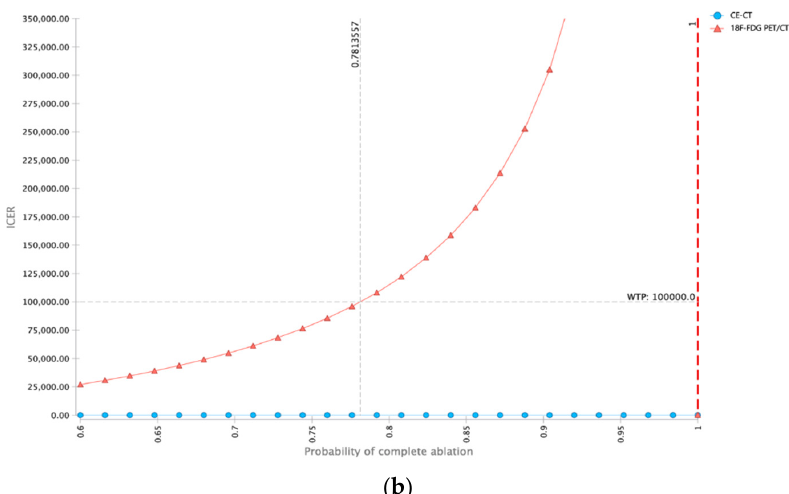
Figure 2. Deterministic sensitivity analysis. ( a ). Tornado diagram showing the impact of input parameters on incremental cost-effectiveness ratio (ICER) starting from expected value (EV) in base case scenario. For every parameter range investigated, the ICER of 18F-FDG PET/CT remained below the willingness-to-pay threshold of $100,000 per QALY (quality of life year) indicating cost- effectiveness of 18F-FDG PET/CT in this setting. ( b ). Analysis investigating the impact of probability of complete ablation on cost-effectiveness. Especially in patients with high risk of incomplete ablation, 18F-FDG PET-CT is the cost-effective strategy in comparison to CE-CT. ICER, incremental cost- effectiveness ratio; WTP, willingness-to-pay.